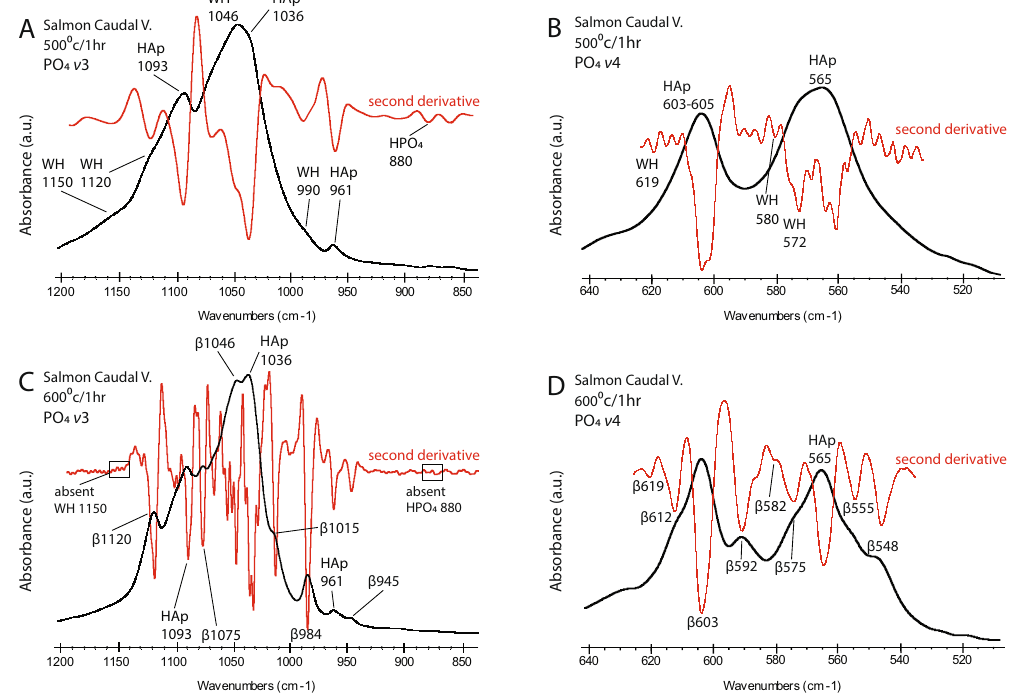
Figure 5. Magnified Representations of the Phosphate v 3 and v 4 FTIR Bands Demonstrating the Formation of Whitlockite and Beta Magnesium Tricalcium Phosphate Phases in Heat Treated Atlantic Salmon Vertebrae. ( A ) PO 4 v 3 band of a salmon caudal vertebra treated at 500 °C; diagnostic WH shoulders appear at 1,150 cm –1 and 990 cm –1 ; the presence of HPO 4 demonstrated by the 880 cm –1 peak distinguishes WH from β MgTCP; ( B ) changes in the PO 4 v 4 band of a salmon caudal vertebra treated at 500 °C; ( C ) PO 4 v 3 band of a salmon caudal vertebra treated at 600 °C; loss of the diagnostic 1,150 cm –1 WH peak and the 880 cm –1 HPO 4 peak and appearances of the 984 cm –1 and 945 cm –1 peaks signify a shift from WH to β MgTCP at 600 °C; ( D ) changes in the PO 4 v 4 band of a salmon caudal vertebra treated at 600 °C; abbreviations: HAp = hydroxylapatite; WH = whitlockite; β = beta magnesium tricalcium phosphate; HPO 4 = hydrogen